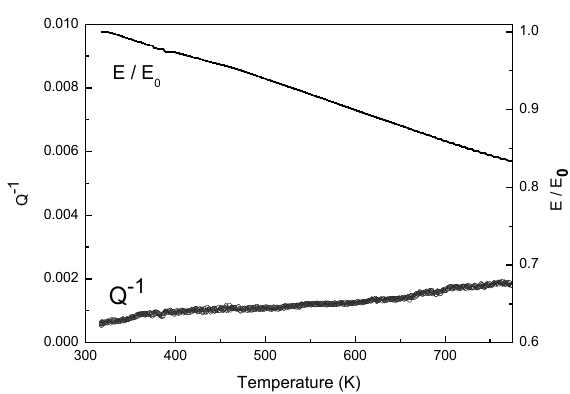
Figure 1. Trends of Q −1 and E / E 0 determined in tests carried out on hollow reeds of AISI 316